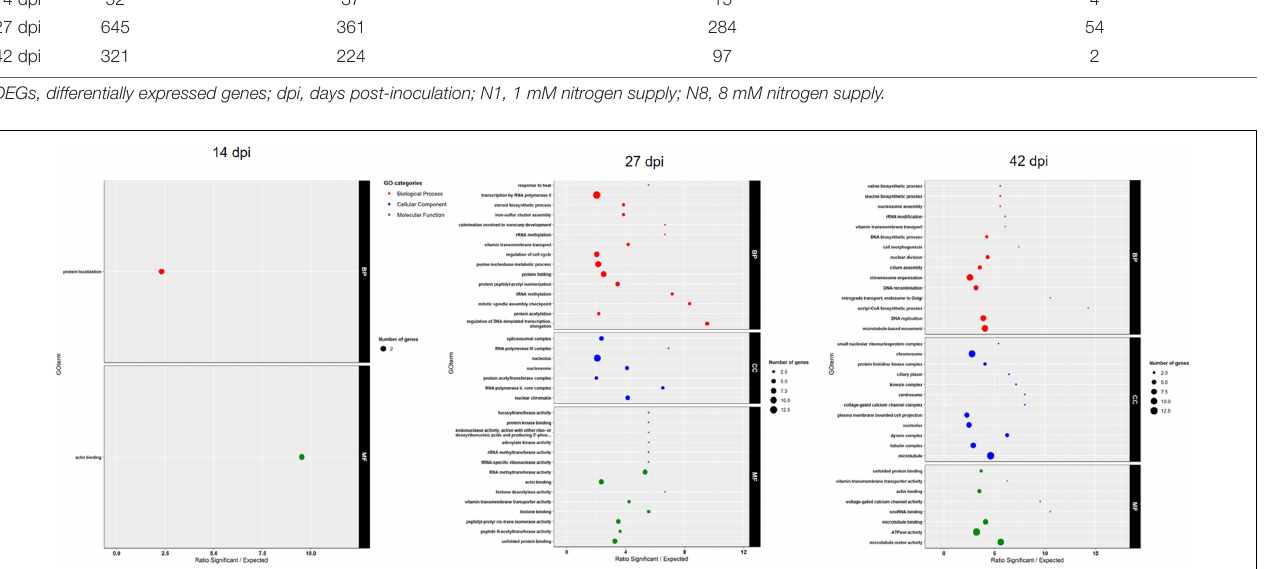
DEGs between N1 and N8 described in Supplementary Table 3 ) whose expression profiles quantitatively varied in function of N conditions but independently of host